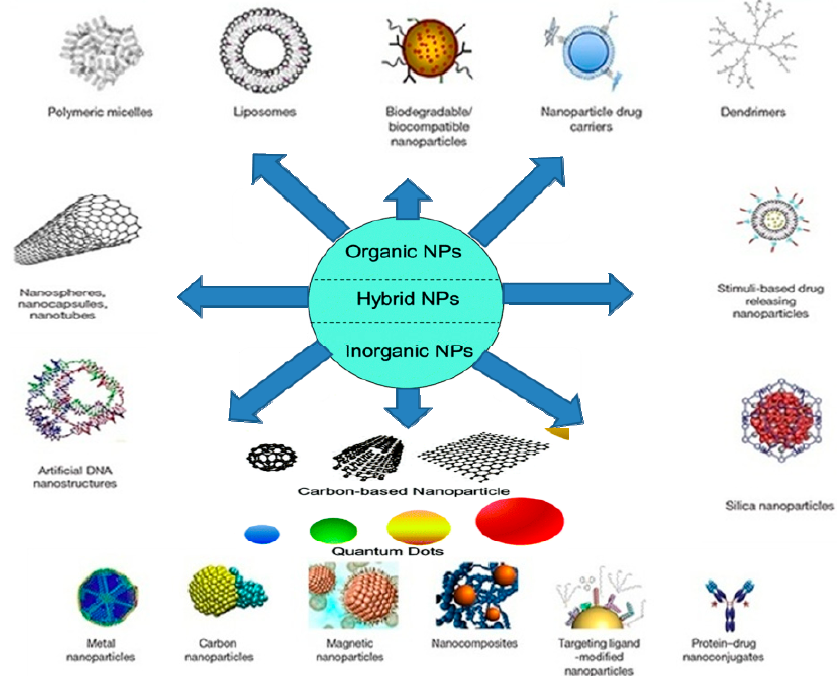
Figure 3. Schematic illustration of different types of nanomaterials used in biomedicine.